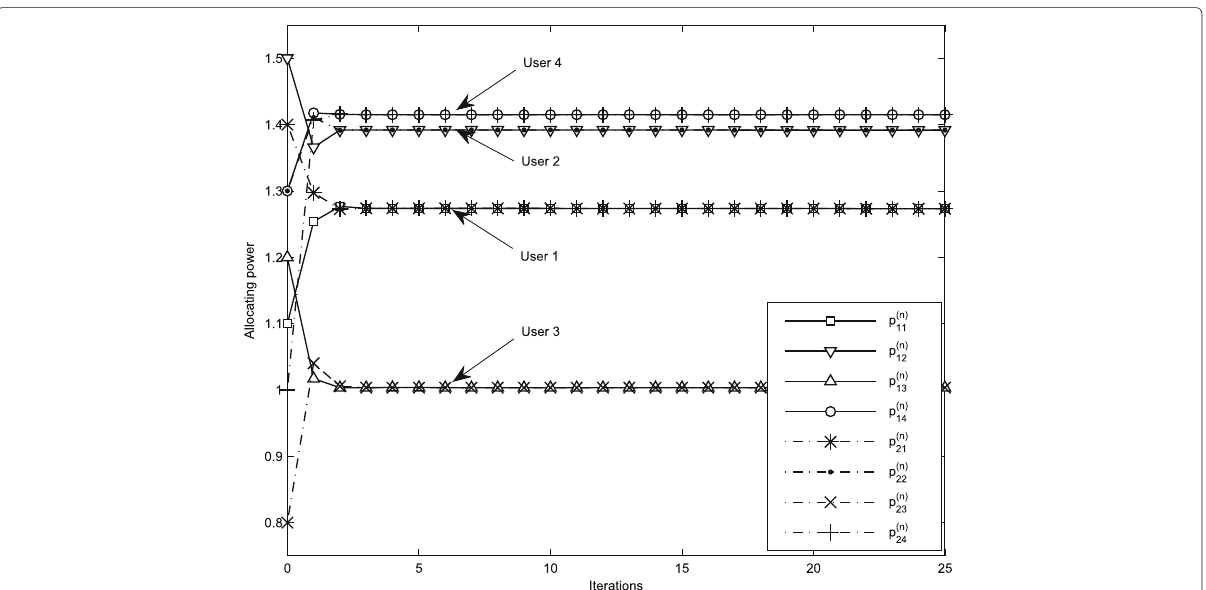
Fig. 2 The power allocation profile versus iterations of IWFA from two different sets of initial points. Figure 2 shows the allocating power of four users versus iterations considering two different initial points. The solid lines and the dotted lines represent different allocating power results for four users under different initial points